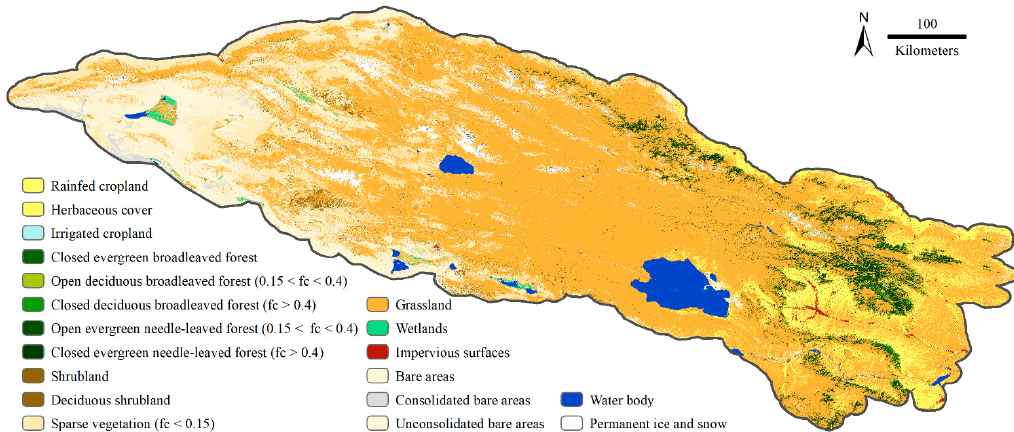
Figure A1. Land cover and land use in the study area.